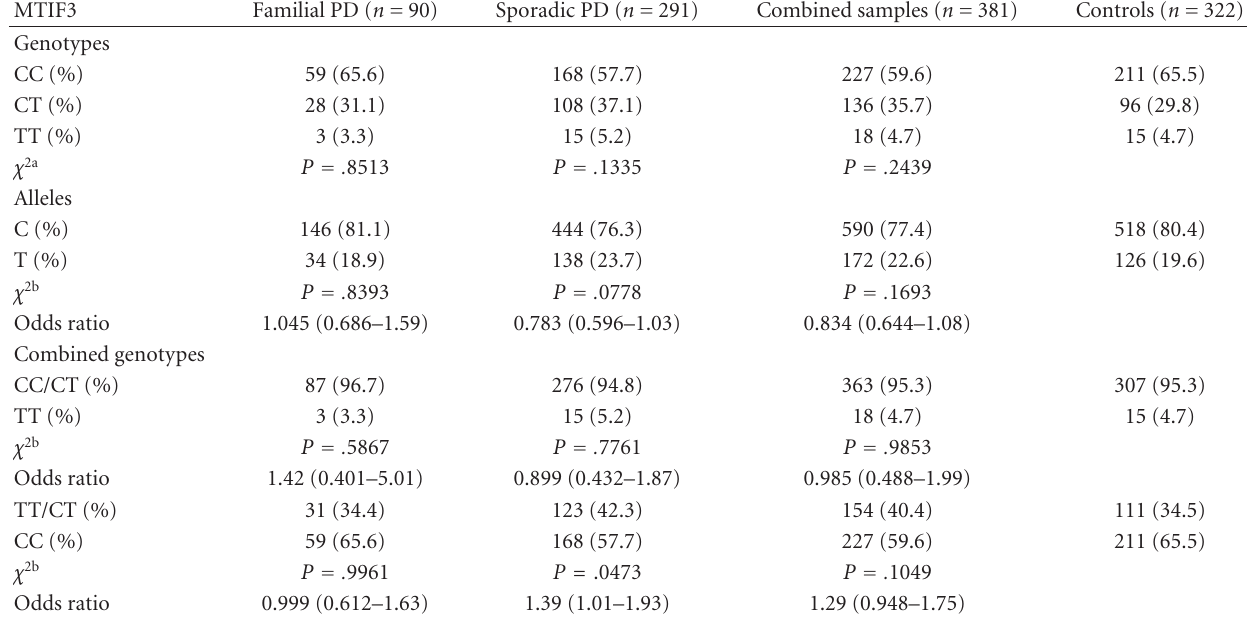
Table 1: Association analysis of MTIF3 rs7669 genotype and allele frequencies in Parkinson’s disease